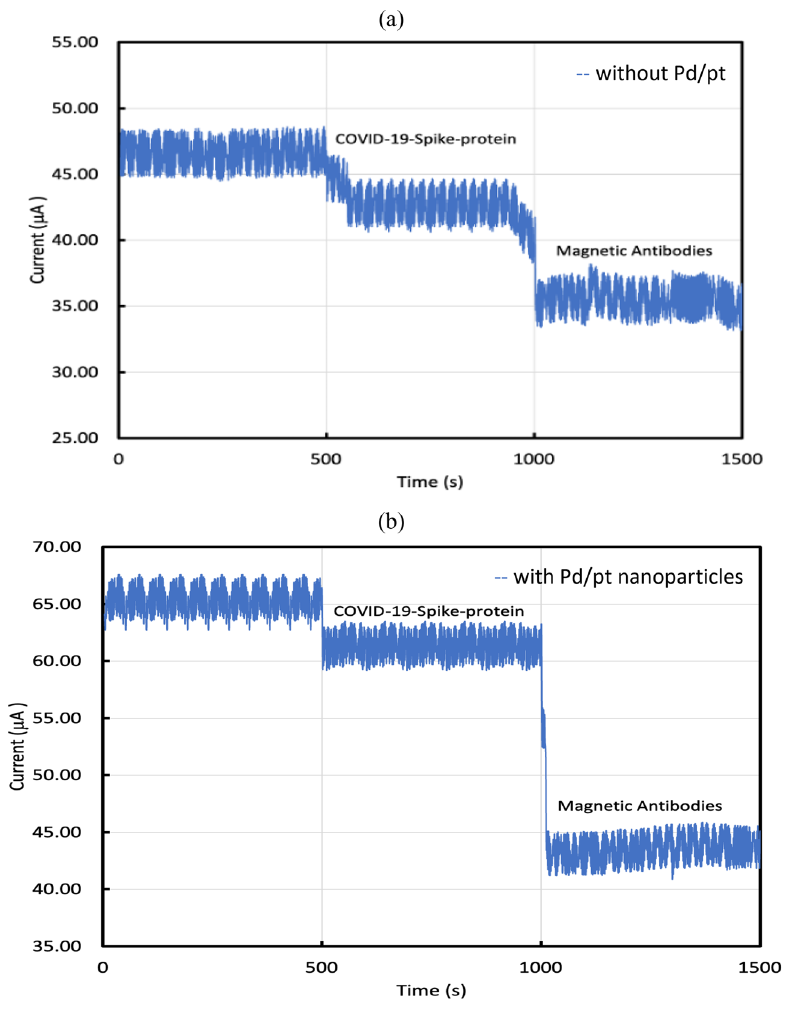
Figure 11. Variation in the drain current due to a 0.4 μL drop of 1 pg/mL of COVID-19 spike antigen for GO-FET biosensor functionalized with COVID-19 spike antibody ( a ) without nanoparticles, and ( b ) with Pd/Pt